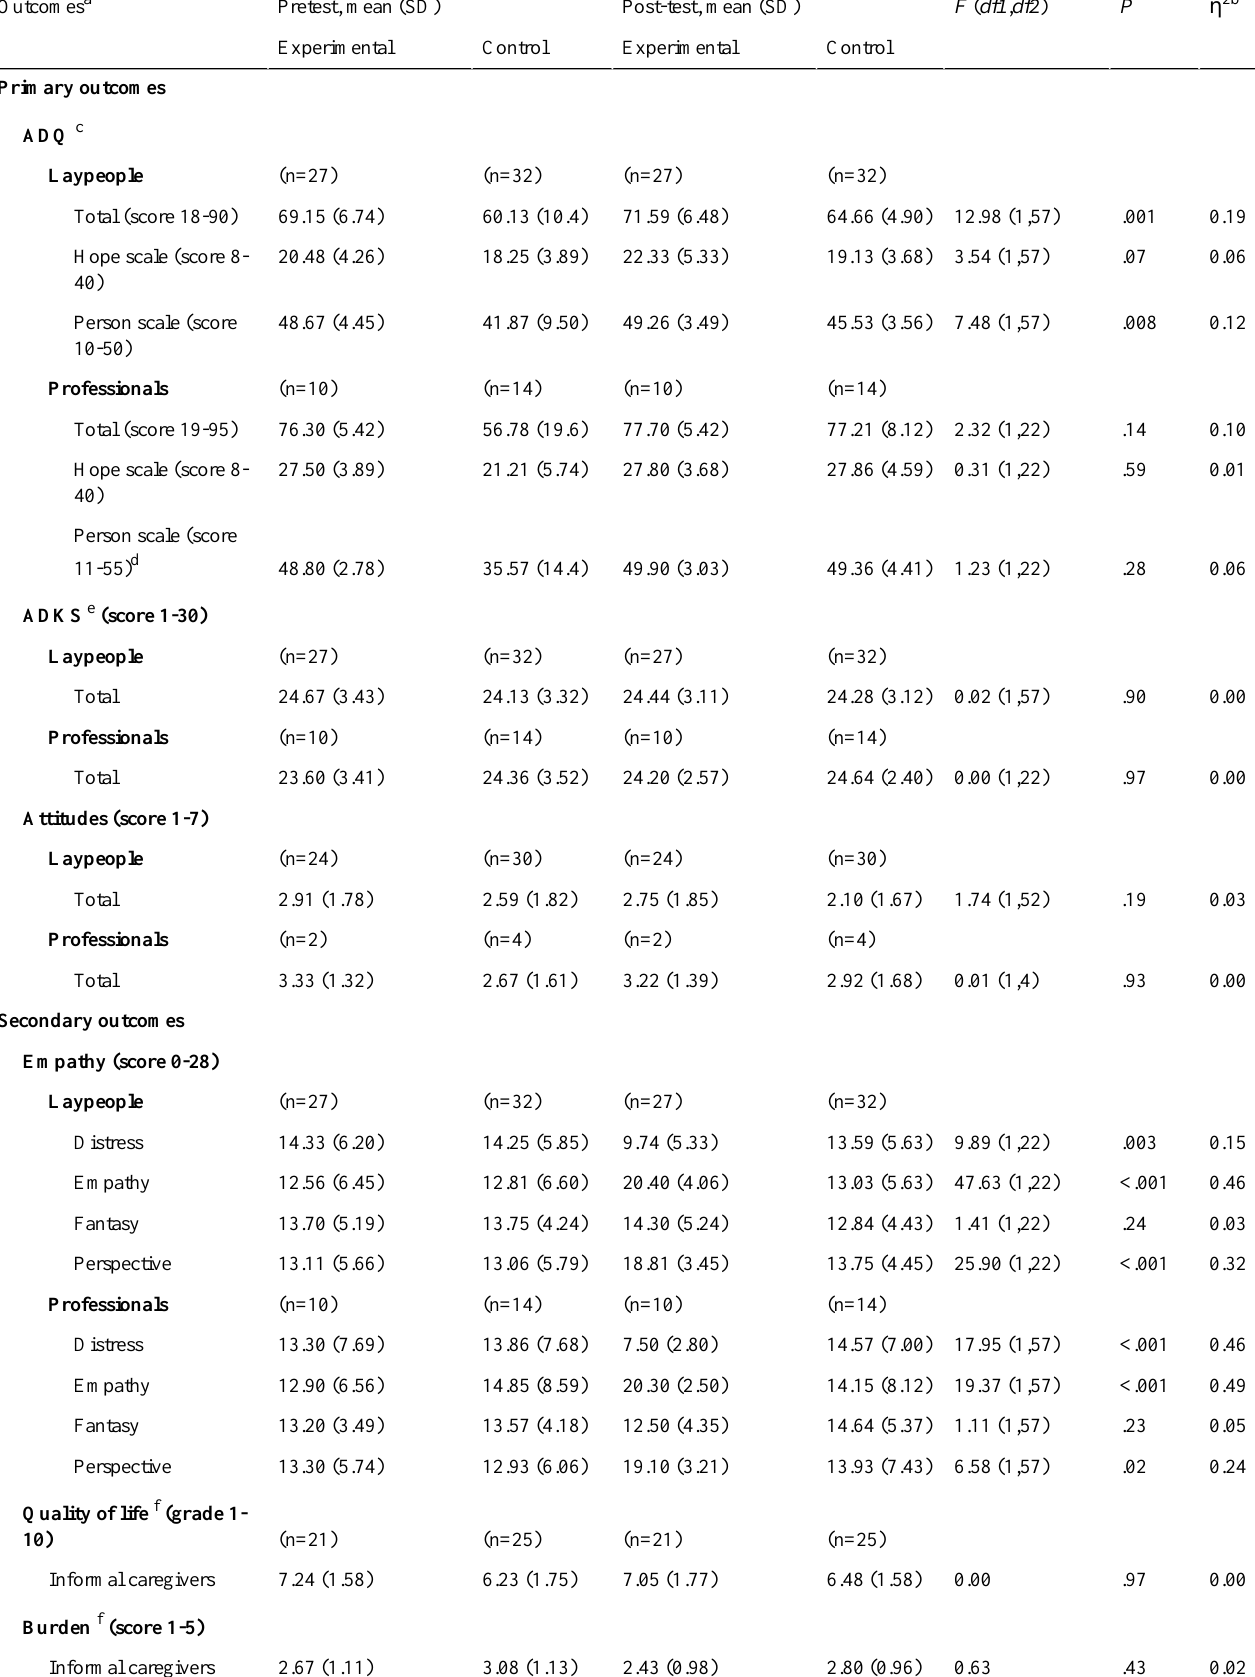
Table 5. Impact of STAR training on outcome measures for laypeople and professionals (Netherlands and United Kingdom